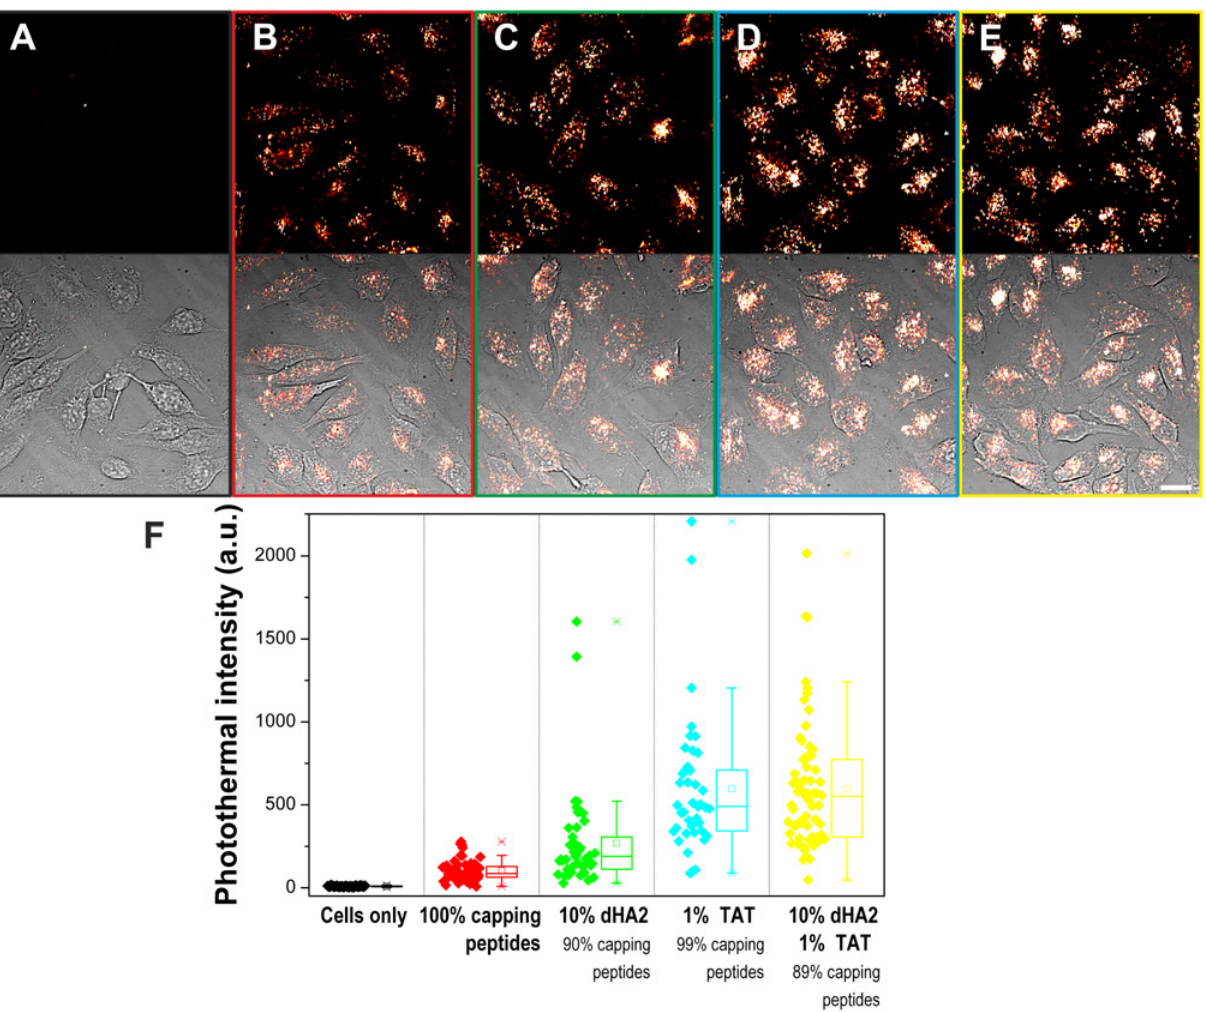
Fig 1. Intracellular delivery of gold nanoparticles assisted by monolayer functionalisation with HA2/TAT peptides. HeLa cells were incubated with/ without 5nm nanoparticles (500nM) functionalised with either capping peptides (CALNN: CCALNN-PEG at a 4:1 molar ratio) or with a combination of dHA2 and/or TAT functional peptides with capping peptides for 3h, fixed and imaged by photothermal microscopy. (A-E) Images of the nanoparticles uptake by HeLa cells, scale bar represents 20 μ m. Top: photothermal image; bottom: overlay of bright field and photothermal images. (A) Cells without nanoparticles. (B) Cells incubated with CALNN: CCALNN-PEG 4:1 coated nanoparticles. (C) Cells incubated with 10% CCALNN-dHA2 coated nanoparticles. (D) Cells incubated with 1% CALNN-TAT coated nanoparticles. (E) Cells incubated with 10% CCALNN-dHA2 + 1% CALNN-TAT coated nanoparticles. (F) Quantification of the internalisation of gold nanoparticles for the conditions shown in (A-E), measured via the mean photothermal intensities of individual cells (over 40 cells for each condition, each data point represents one cell). All conditions are significantly different from one another except the pair (1% TAT, 10% dHA2-1% TAT). Dataset available on figshare (10.6084/m9.figshare.1088379).